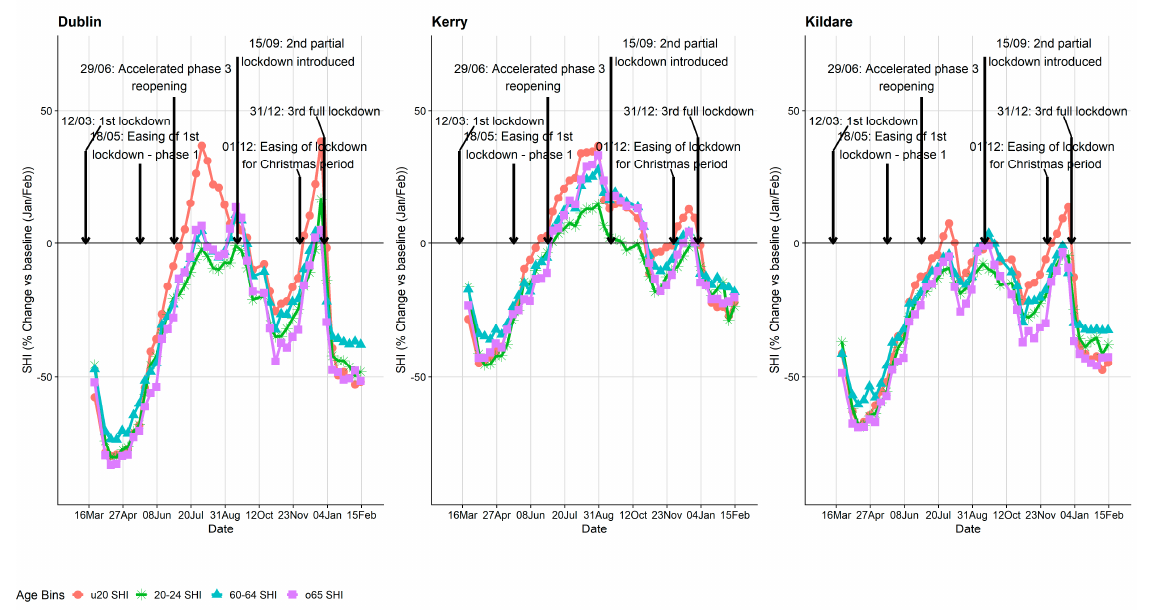
Figure 5. Mobility plot—percentage change in SHI compared to their baseline figures (January/February 2020) for counties Dublin, Kerry and Kildare by the two youngest and oldest age groups (for clarity). Plots of all 26 Irish counties are included in the supplementary material.